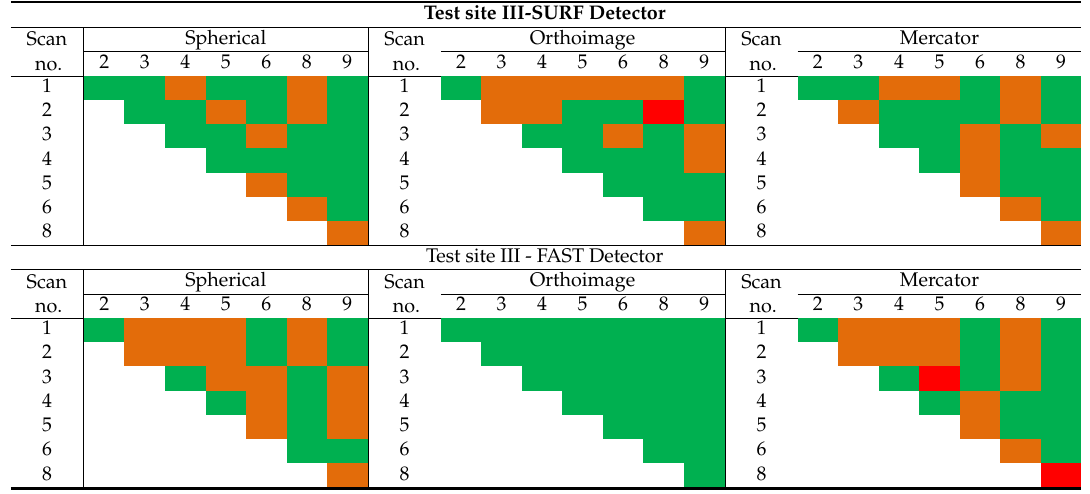
Table 7. The correctness of automated connecting of scans for Test Site III (both scenarios): Green, correct matching (full-registration), orange-preliminary orientation requiring the final registration using the ICP method, red, no matching, and "x", means no connection for scans (no overlap). Test site III-SURF Detector Orthoimage Scan Spherical Scan Scan no. no. no.